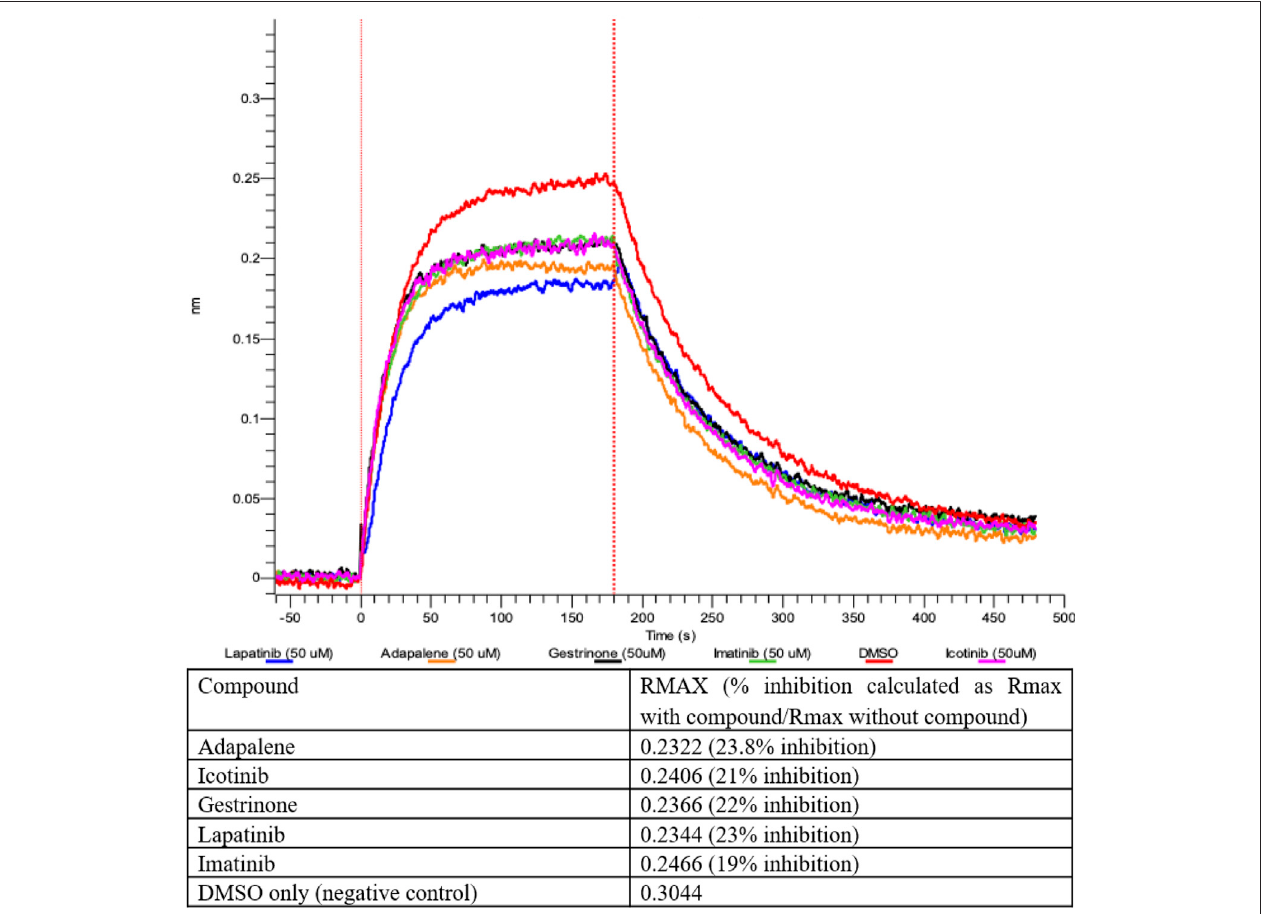
FIGURE 4 | Inhibition of ACE2-RBD binding after pre-treatment with 50 μ M compound measured by Biolayer interferometry.